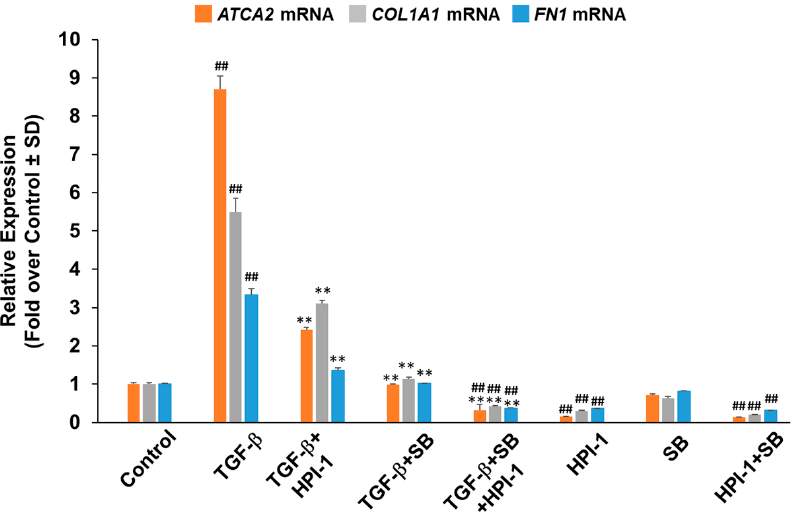
Figure 2. HPI-1 and SB-431542, known inhibitors of Hh and TGF- β signaling, reduce the basal and TGF- β -induced expression of fibrotic genes . LL97A cells were treated with TGF- β 1 (10 ng/mL) in F12K medium containing 1% FBS in the absence or presence of HPI-1 (5 µ M) or SB-431542 (SB) (5 µ M) as indicated. After 48 h, RNA was analyzed by Q-RT-PCR for gene expression and nor- malized to GAPDH. Data from a representative experiment are reported as the mean of triplicate determinations ± SD (## p < 0.01 vs. control; ** p < 0.01 vs. TGF- β ).